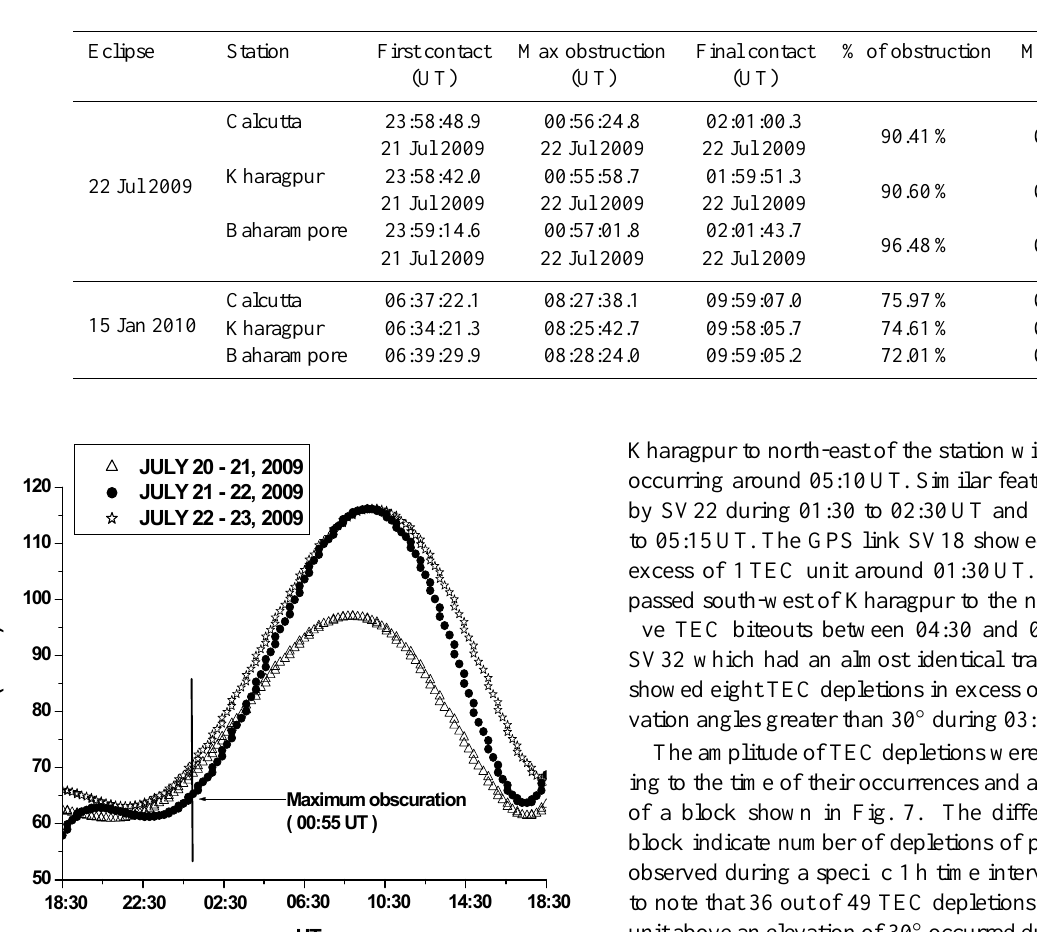
Table 1. The details of the 22 July 2009 and 15 January 2010 eclipses as observed from the three stations, namely, Calcutta, Kharagpur and Baharampore.